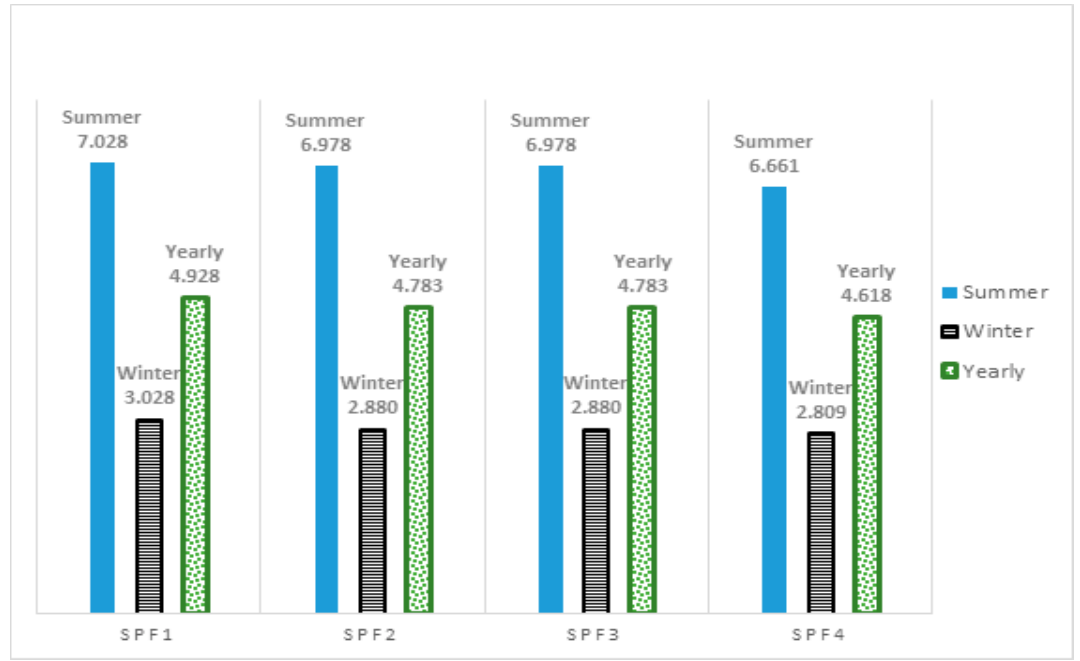
Figure 14. Seasonal Performance Factor (SPF) values during cooling season (summer), heating season (winter) and the whole year according to the SEPEMO project definition [38].